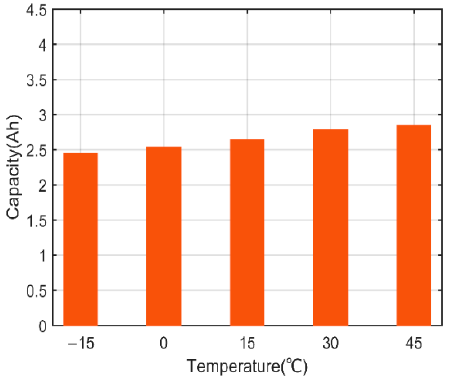
Figure 13. Battery cell1 discharge voltage at different temperatures.